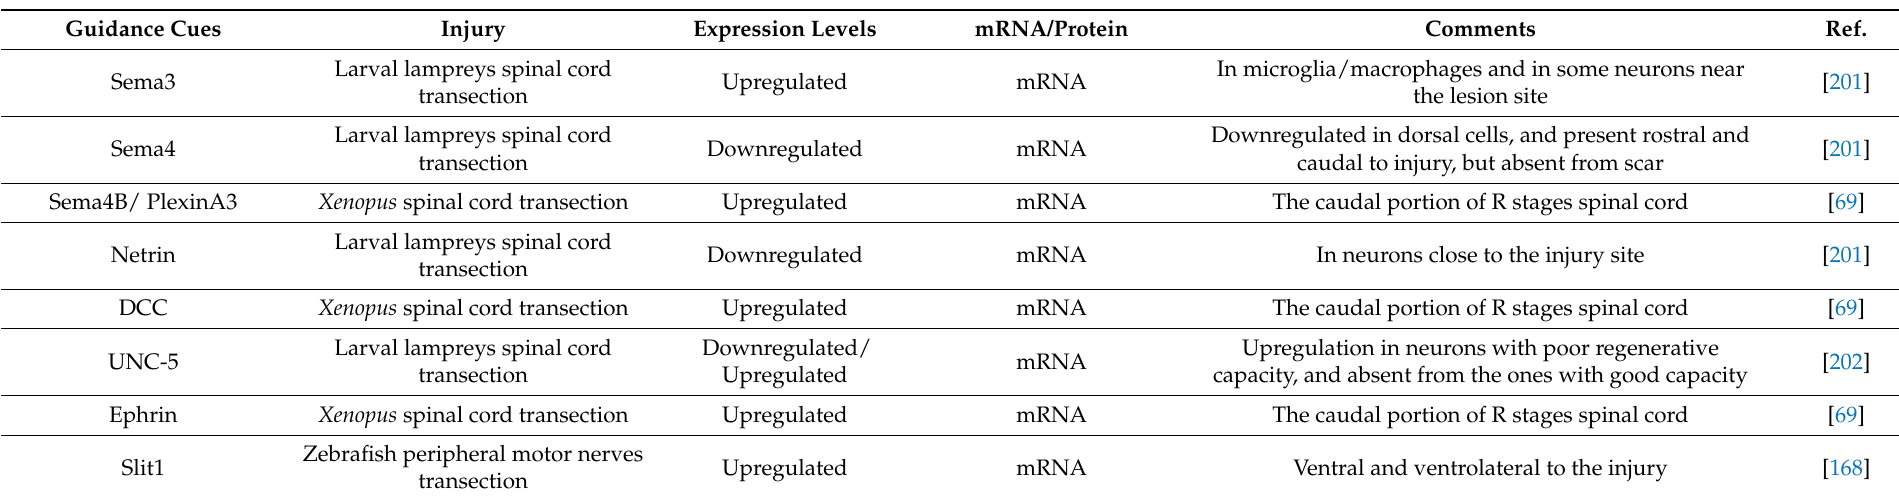
Table 3. Differential expression of guidance cues after nervous system injuries in regenerative animal